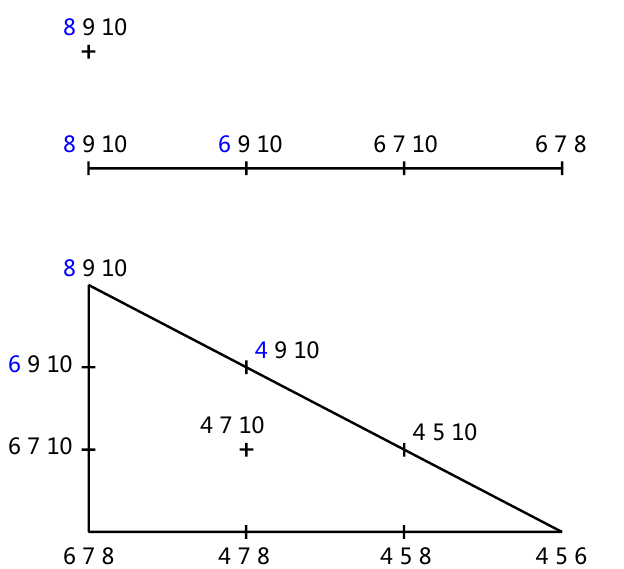
Figure 17 . Solid 0-, 1-, 2-simplices of level 3 with growing parameters (8), (8 ; 6), (8 ; 6 ; 4)